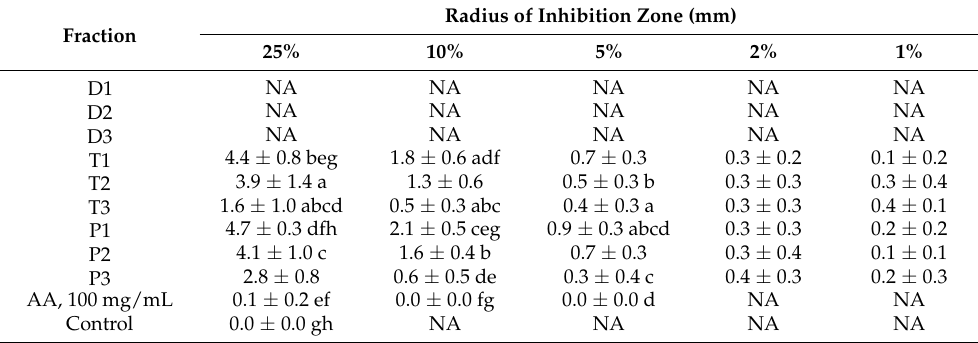
Table 2. Inhibition zones of the pyrolysis fractions against Salmonella Infantis.